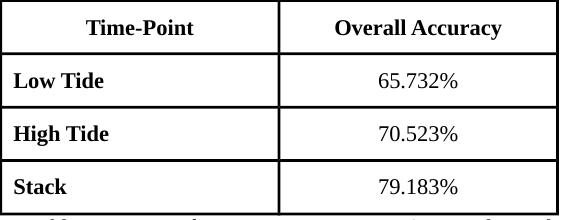
Table 3. SCP Confusion Matrix Accuracy (Low Tide, High